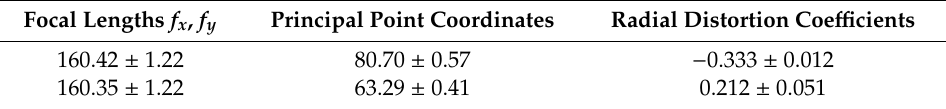
Figure 5. Sample image checkerboard image used for infrared camera calibration. ( a ) Raw and ( b ) undistorted using the estimated radial distortion coefficients. Table 3. Estimated intrinsic camera parameters after calibration procedure (length unit in